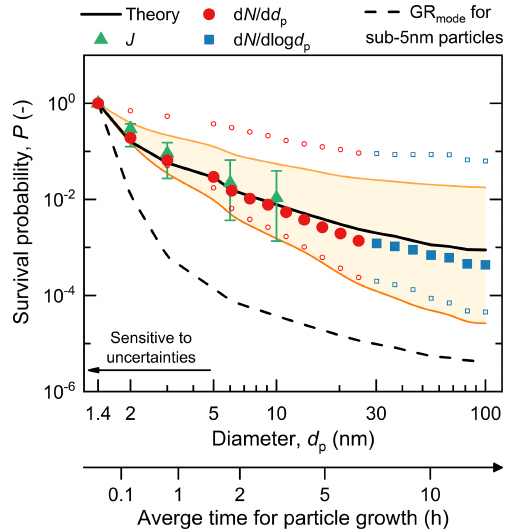
Figure 6. Measured and theoretical survival probabilities of new particles in urban Beijing. The markers and lines show the me- dian survival probability obtained from 65 NPF events. The vari- ation bars, open markers, and the shaded area indicate the 25%– 75% variation range of the survival probabilities computed using J , d N/ d d p or d N/ dlog d p , and theory, respectively. The difference between the solid and dashed lines for theoretical survival proba- bilities is caused by the difference between the sub-5nm particle growth rate retrieved using the appearance time method and the mode-fitting method. A non-linear horizontal axis shows the local time corresponding to the growing particle size, indicating atmo- spheric variations during the measured new particle formation and growth.